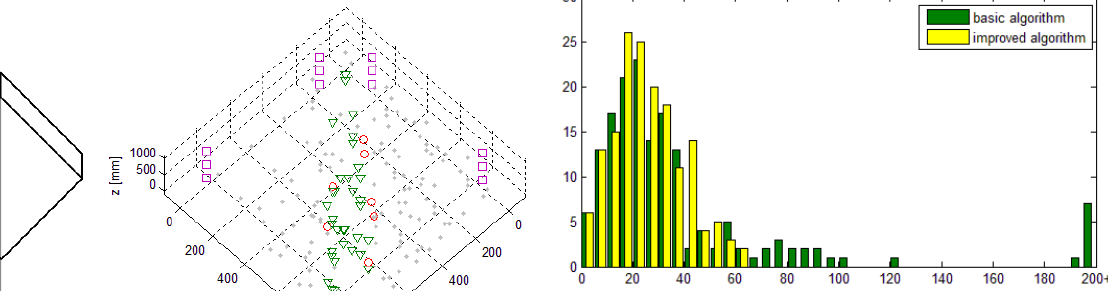
Figure 12. Histograms of errors of basic and improved algorithm for the chosen test series.